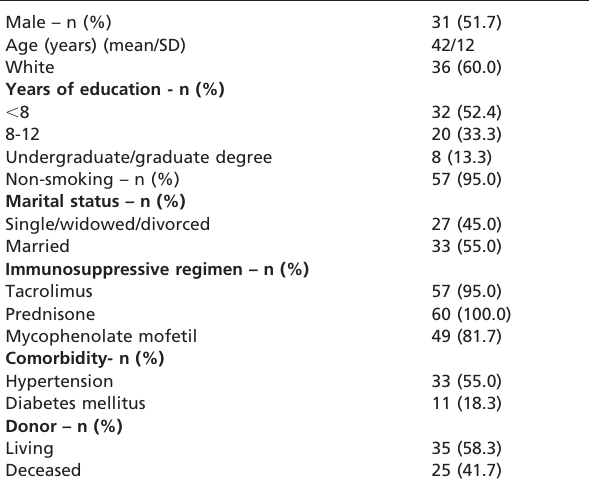
Table 1 - Patient characteristics.